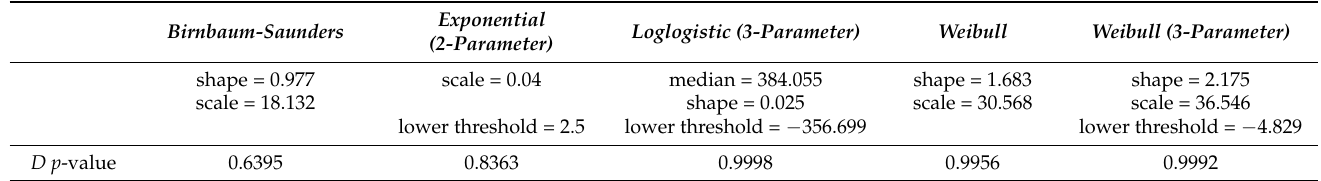
Table 2. Parameters of the distribution functions fit the seed dispersal distance data with respective